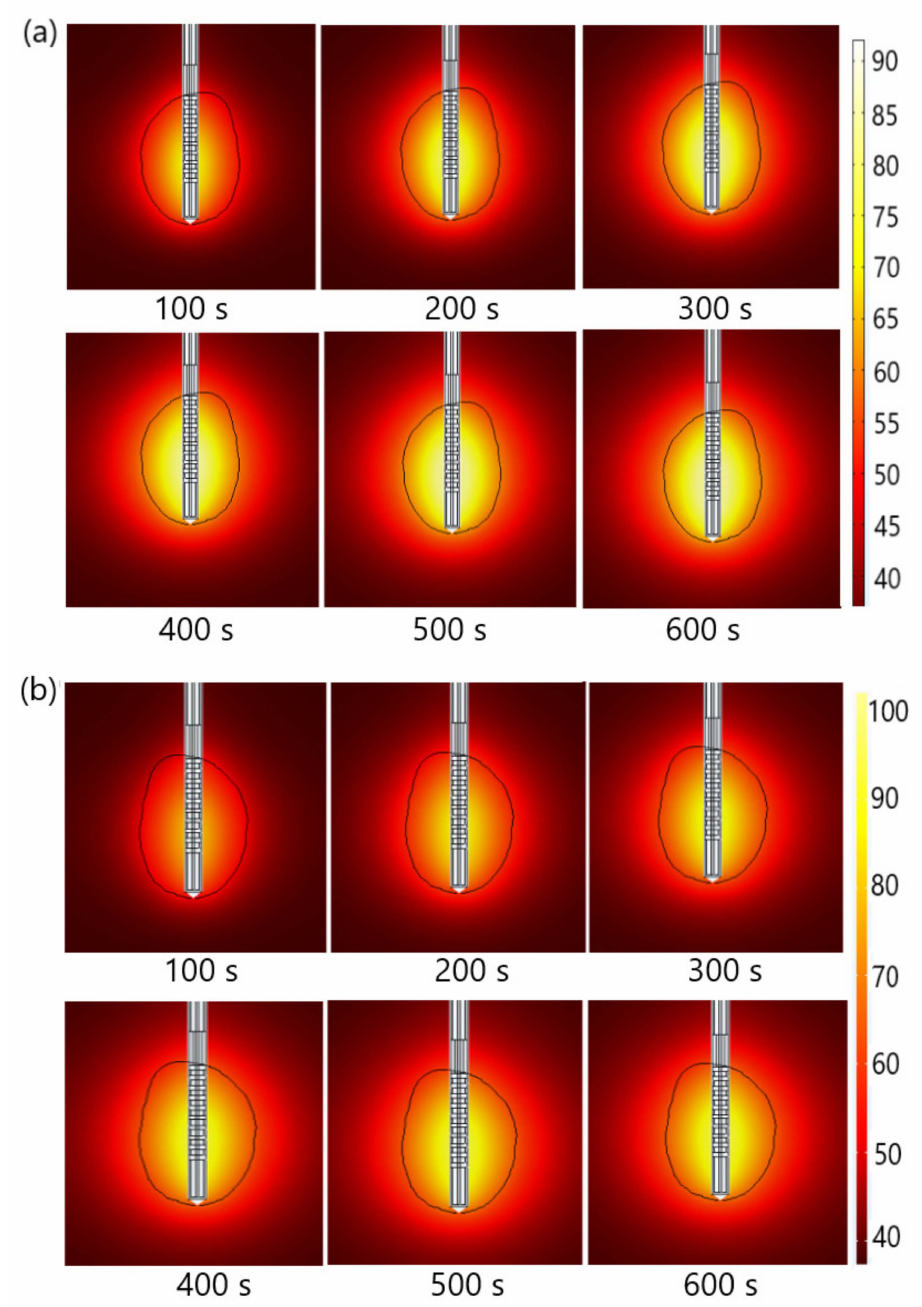
Figure 8. Time evolution of the temperature distribution (in ◦ C) for tumors ( a ) 1.07 [51]) and ( b ) 1.03 [51] treated by MWA at a frequency of 2.45 GHz. The boundary of the tumor tissue is marked by a black